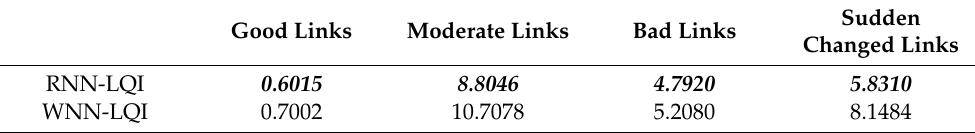
Table 1. RMSEs of LQI prediction under different link